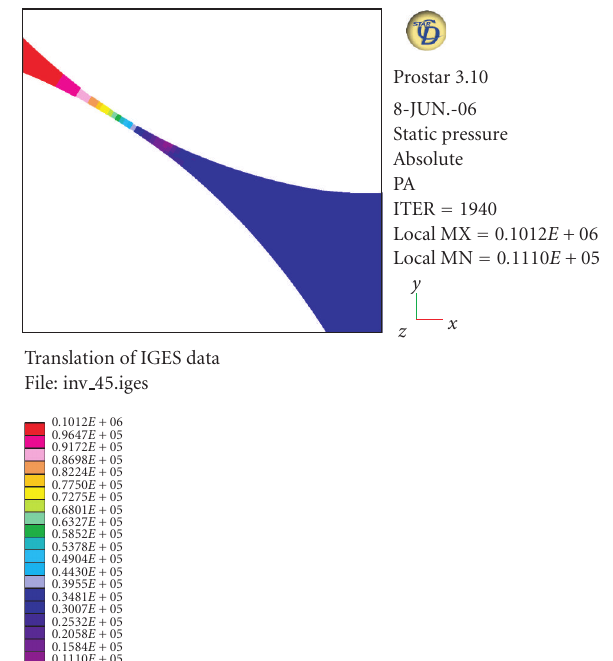
Figure 10: Static pressure contours for rotor-rotor gap.